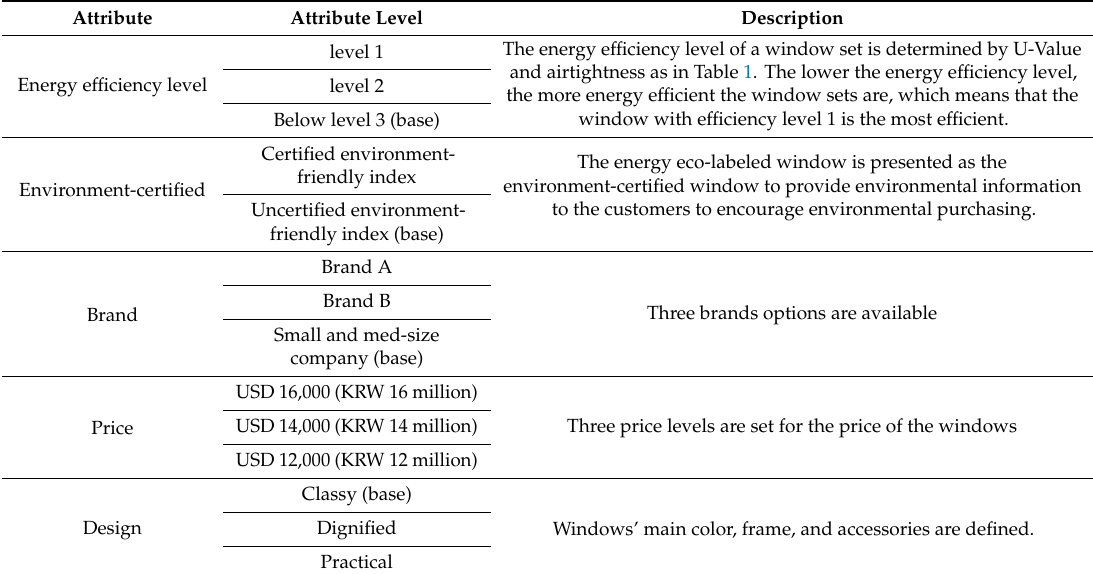
Table 2. Window sets’ attributes and levels used for the conjoint